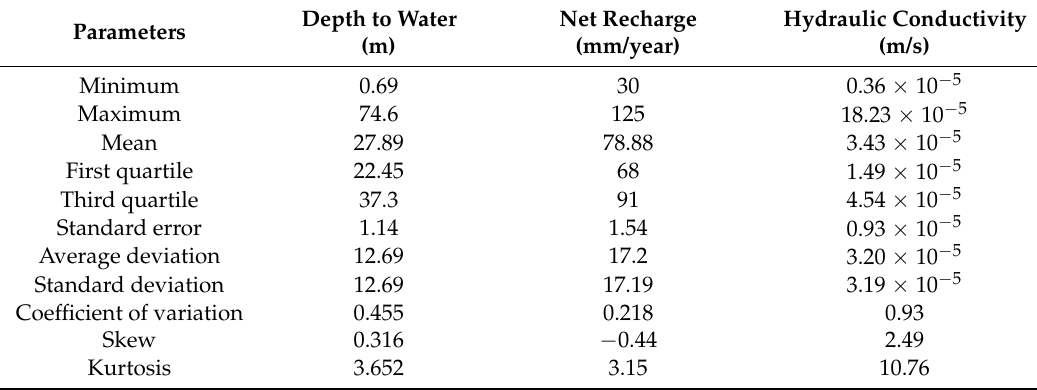
Table 5. Summary of the best-fit models for parameters Depth to water, net Recharge and hydraulic Conductivity.